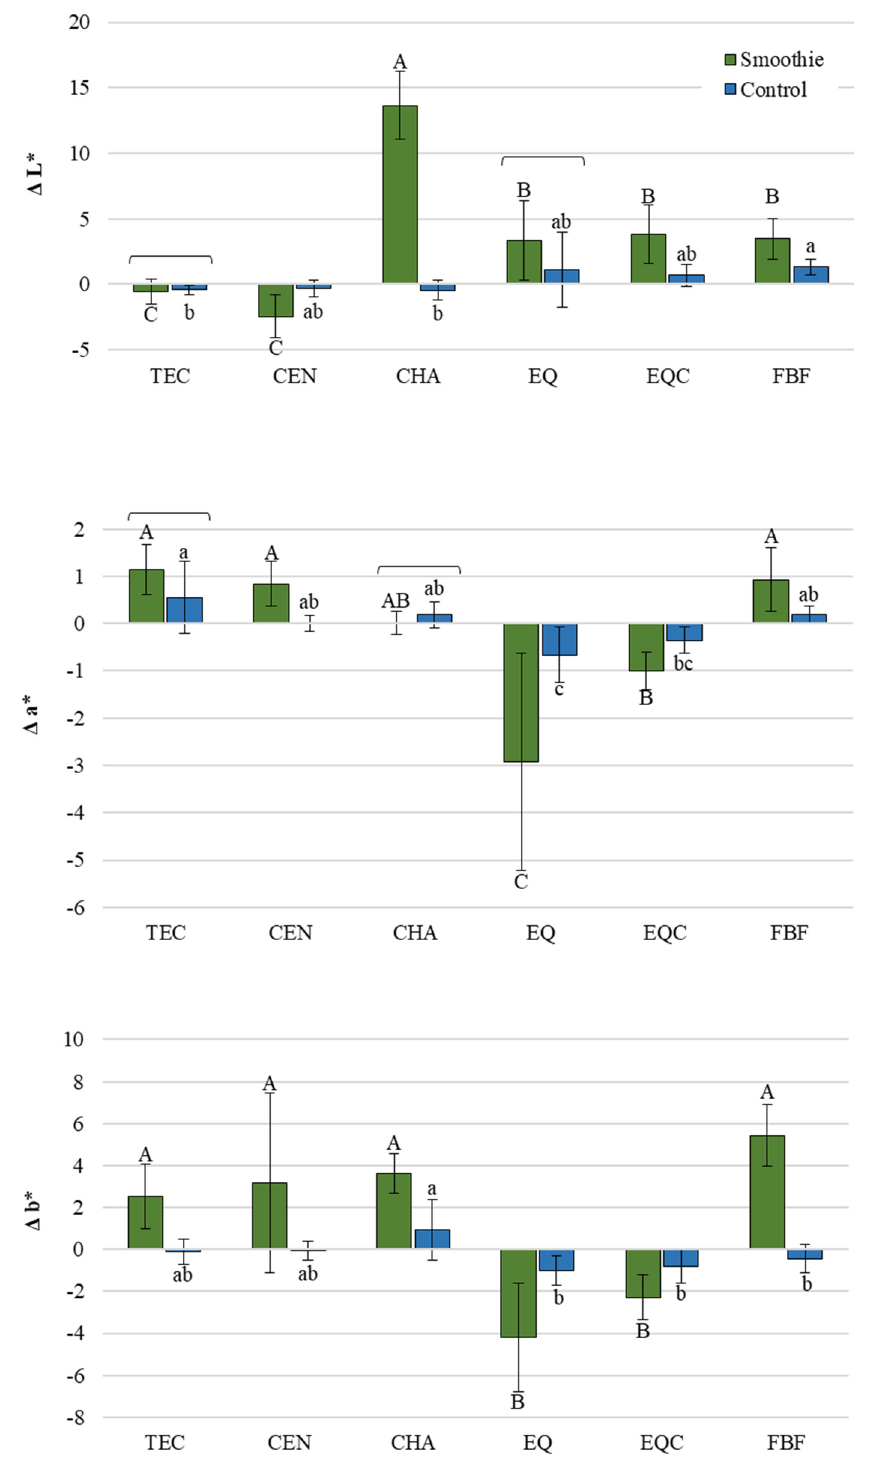
Figure 5. ∆ L*, ∆ a*, and ∆ b* (mean values ± 1 standard deviation, n = 10) representing shifts along individual color axes between 24 h and 1 month. Square brackets indicate statistically similar values. Same uppercase letters indicate statistically similar values within the smoothie group. Same lowercase letters indicate statistically similar values within the control group. TEC: Tetric EvoCeram, CEN: Cention, CHA: Charisma Classic, EQ: Equia Forte HT Fil Uncoated, EQC: Equia Forte HT Fil Coated FBF: Filtek Bulk Fill.